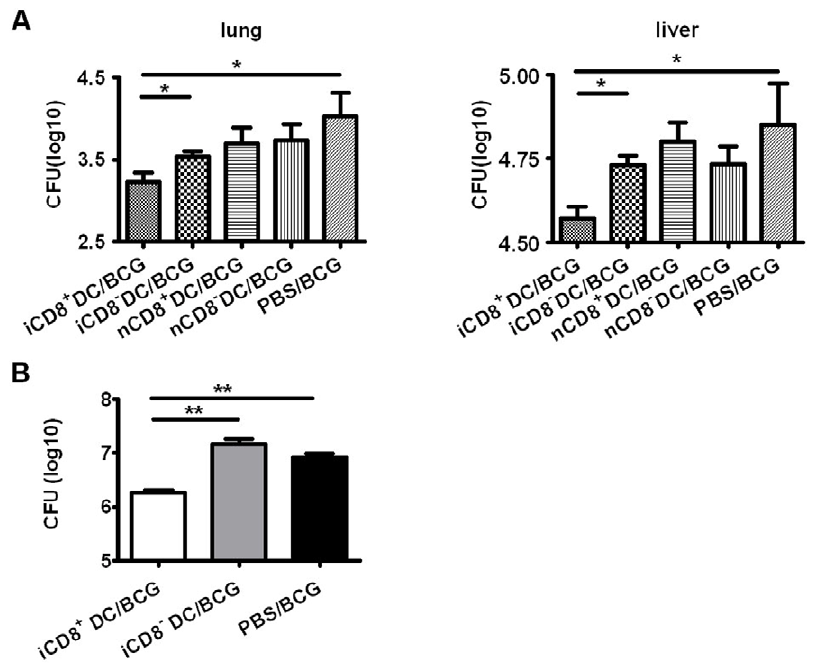
Figure 4. Adoptive transfer of iCD8 + DC, but not iCD8 2 DC, reduced bacterial growths in recipients following either i.v. or i.n. challenge infection. DC subsets were sorted from BCG-infected (i.v.) mice or naı¨ve mice and adoptively transferred to syngeneic recipients (C57BL/6, n=4/group) by i.v. (A&B, 5 6 10 5 DC/mouse) or i.n. routes (C, 2 6 10 5 DC/mouse). Mice were challenged with BCG through i.v. (A&B) or i.n. (C) routes, respectively, as described in Materials and Methods. All mice were sacrificed at day 21 post challenge infection. Homogenized lung or liver tissues were measured for BCG CFU. The CFUs of BCG were converted to logarithmic values and presented as mean 6 SD of each group. One representative experiment of three independent experiments is shown. * p , 0.05;**, p ,